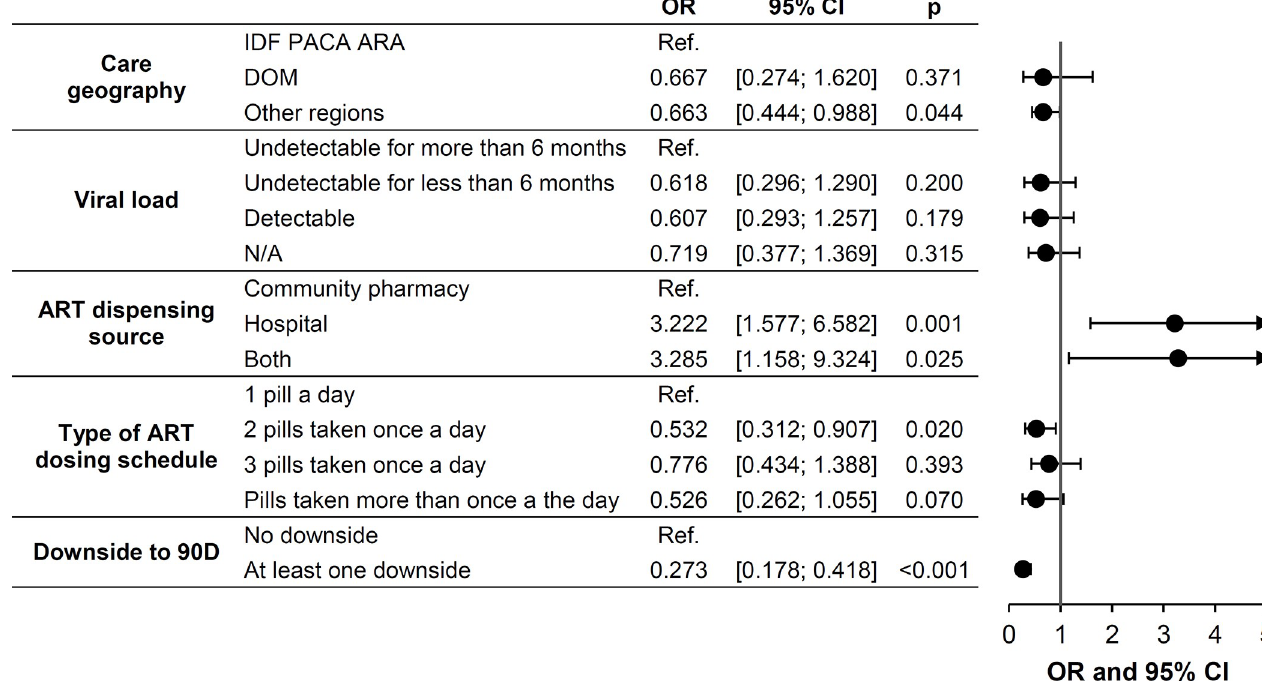
Fig 2. Characteristics of in-sample PLHIV and in-sample people on PrEP stratified as endorsers vs non-endorsers of 90-day ART dispensing (n = 1074). Multivariate analysis. ARA: Auvergne-Rhoˆne-Alpes; ART: antiretroviral; DOM: French overseas; IDF: Iˆle-de-France; N/A: does not apply; PACA: Provence- Alpes-Coˆte d’Azur. IDF, PACA, ARA are regions of high HIV prevalence in France.